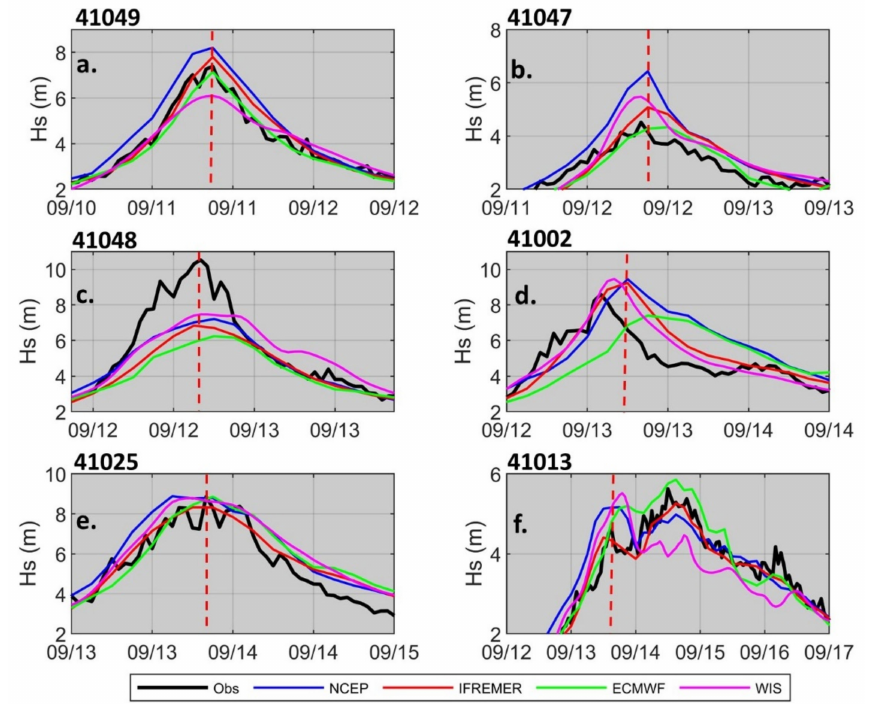
Figure 14. Buoy-model time-series comparisons of Hs for buoys ( a ) 41049, ( b ) 41047, ( c ) 41048, ( d ) 41002, ( e ) 41025 and ( f ) 41013 during Hurricane Florence. The red dotted vertical line denotes the time used to assess the 1D wave spectra in Figure